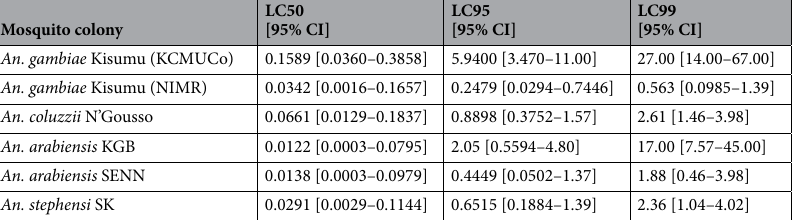
Table 1. Lethal concentrations (%) of broflanilide (μg/ml) required for mortality of six Anopheles insectary strains.